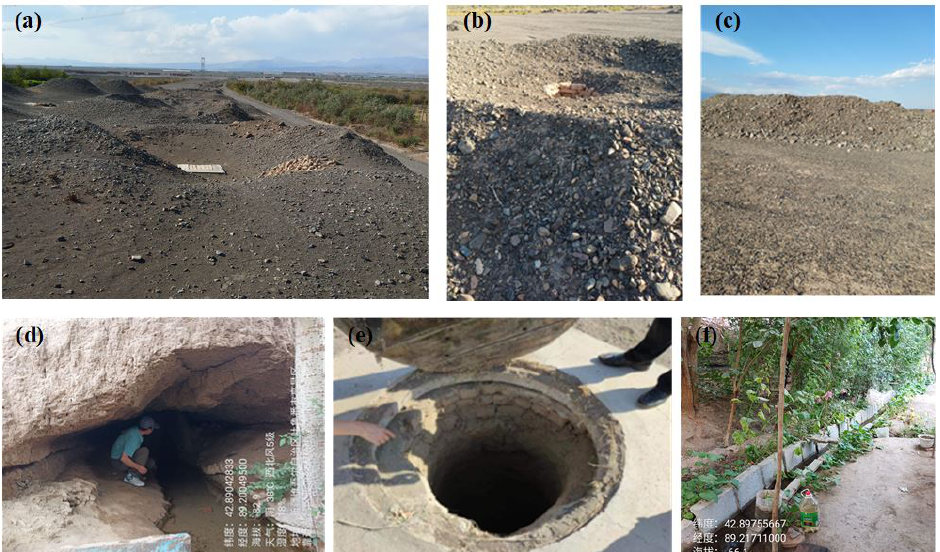
Figure 3. Ground photos of the karez system. Panel ( a , b ) show side and top views of the karez shaft. The shaft cover in ( a ) is square, while the shaft in ( b ) has no cover. Panel ( c ) is a side view of the karez shaft, and the wellhead is usually positioned above ground level because during the construction of a karez, a small amount of soil excavated from underground is piled around the wellhead. Panel ( d ) shows the position of the karez dragon mouth. Panel ( e ) is an internal wall view of the karez shaft, with a circular shaft cover. Panel ( f ) shows the open canal of the karez